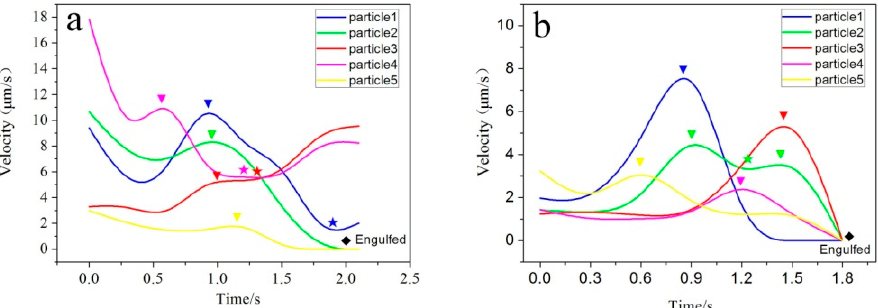
Figure 9. Velocity evolution of particles near the advancing solidification front ( a ) without PMF and ( b ) with PMF.